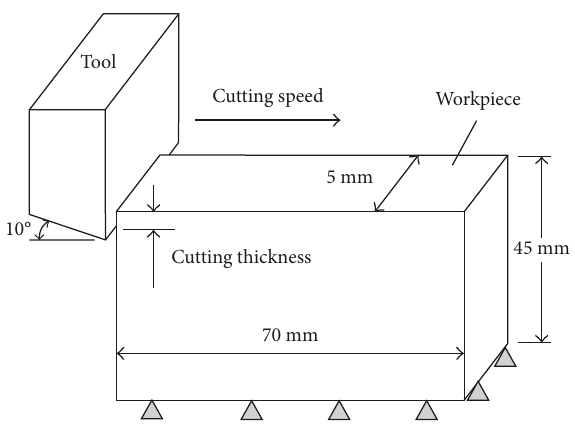
Figure 1: Schematic diagram of orthogonal cutting